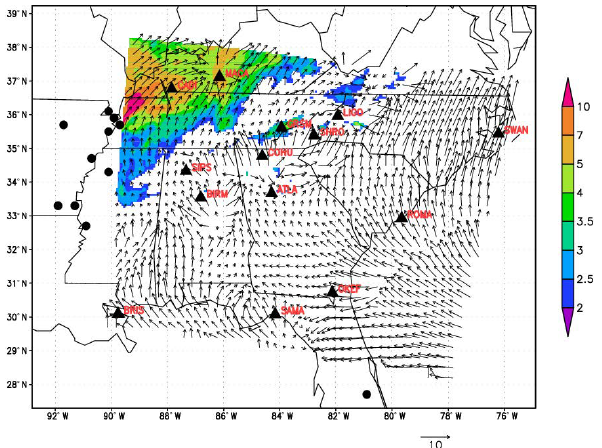
Figure 4. Simulated (cid:49) CO ( > 2 . 0ppb) in the SENEX domain on 24 June 2013 at 20:00UTC overlaid with 2m wind arrows with a 10ms − 1 reference arrow shown in the bottom right. The solid black circle is detected fire hotspots by HMS. The solid triangles labeled with station code represent IMPROVE sites used in model verification calculations.